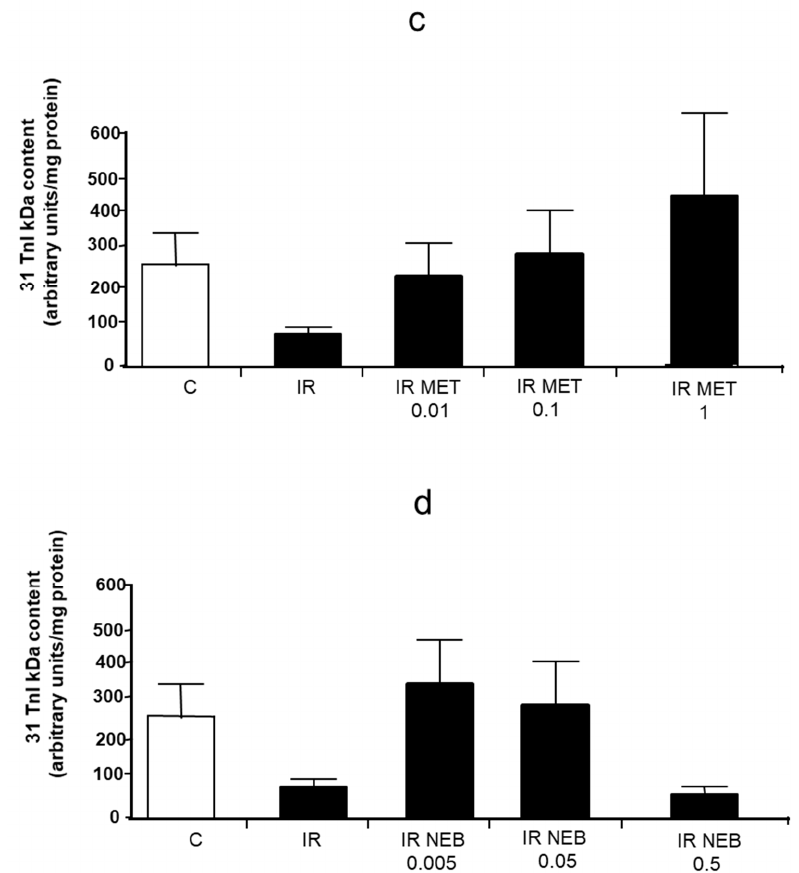
Figure 6. ( a – d ) Effect of carvedilol, metoprolol and nebivolol on troponin I content in heart tissue. ( a ) Densitometric analysis of TnI content in heart homogenates prepared at 30 min of reperfusion after 20 min ischemia in IR CAR 0.1 group as determined by Western blot. ( b ) Representative troponin I (TnI) protein level in heart homogenates prepared at the end of perfusion in IR CAR 0.1 group as determined by Western blot. ( c ) Densitometric analysis of TnI content in heart homogenates prepared at 30 min of reperfusion after 20 min ischemia in metoprolol treated hearts as determined by Western blot. ( d ) Densitometric analysis of TnI content in heart homogenates prepared at 30 min of reperfusion after 20 min ischemia in nebivolol treated hearts as determined by Western blot. Decrease of the level of 31 kDa troponin I was abolished only in the IR-CAR 0.1 µ M group. C—control group, aerobically perfused hearts, IR injury—ischemia-reperfusion injury, IR-CAR 0.1—hearts from IR injury model treated with 0.1 µ M carvedilol, IR-CAR 1—hearts from IR injury model treated with 1 µ M carvedilol, IR-CAR 10– hearts from IR injury model treated with 10 µ M carvedilol, IR-MET 0.01—hearts from IR injury model treated with 0.01 µ M metoprolol, IR-MET 0.1—hearts from IR injury model treated with 0.1 µ M metoprolol, IR-MET 1—hearts from IR injury model treated with 1 µ M metoprolol, IR-NEB 0.005—hearts from IR injury model treated with 0.005 µ M nebivolol, IR-NEB 0.05—hearts from IR injury model treated with 0.05 µ M nebivolol, IR-NEB 0.5—hearts from IR injury model treated with 0.5 µ M nebivolol. * IR vs IR-CAR 0.01, p < 0.05, n = 6,